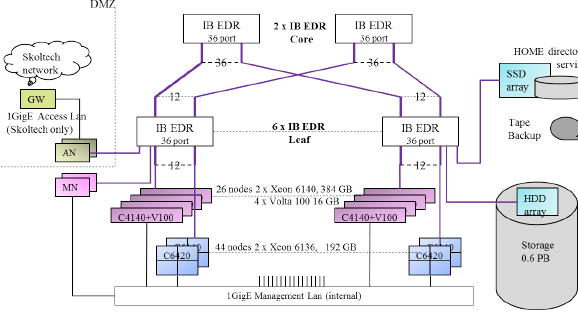
Figure 1: Principle connection scheme. The an and mn nodes are marked explicitly; the cn, gn and other nodes are lumped